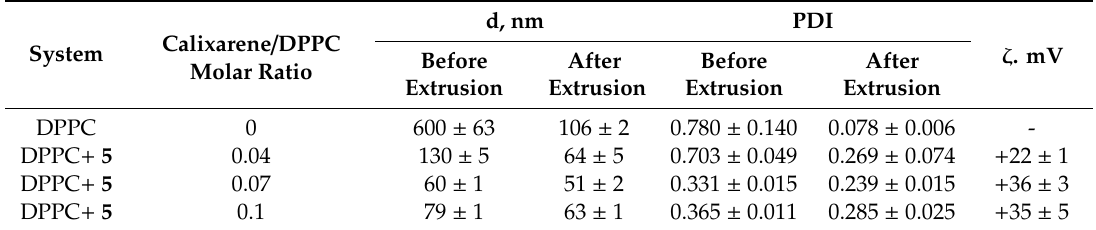
Table 3. DLS and ELS data of aggregates formed by DPPC and calixarene 5